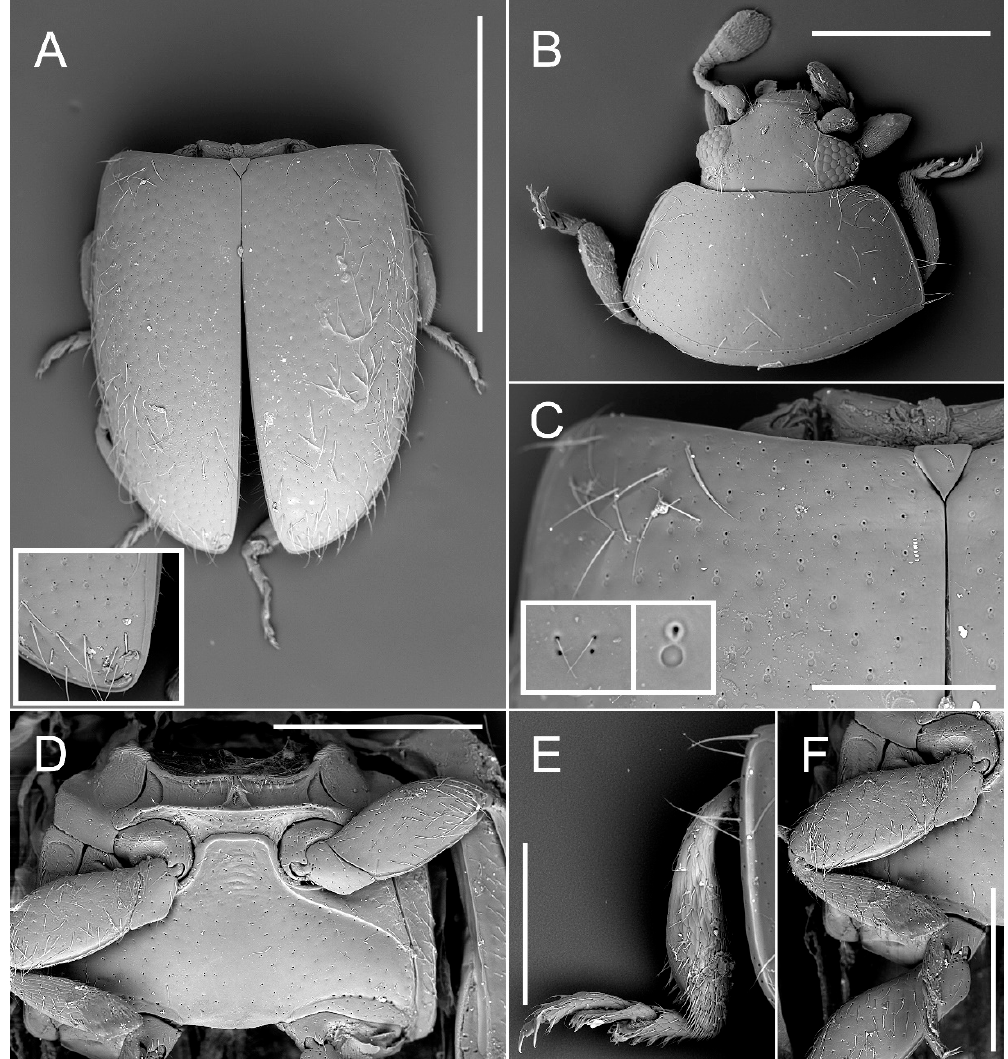
Figure 4. Morphology of Madeirodula atlantica gen. et sp. nov. A , elytra, dorsal with enlarged apex with sutural line. B , head an pronotum, dorsal. C , base of elytra and scutellar shield with enlarged details of elytral surface structures. D , meso- and metaventrite. E , left mid-leg, dorsal. F , right mid- leg, ventral. Scale bars: 1 mm ( A ); 0.5 mm ( B ); 0.4 mm ( D ); 0.2 mm ( C , E , F ).